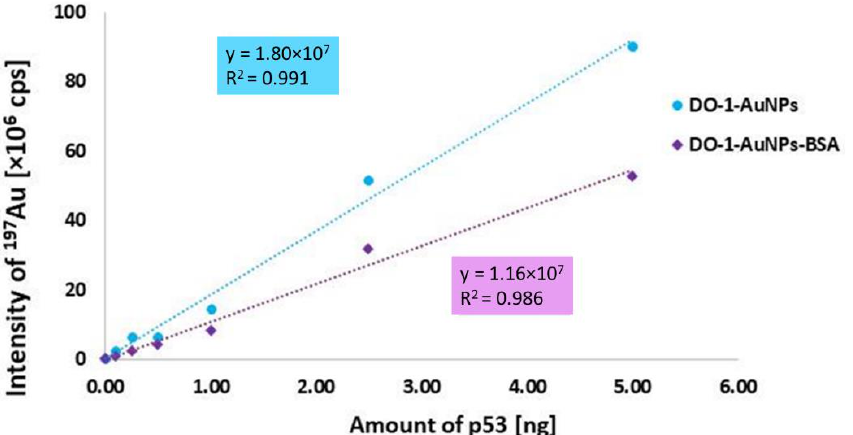
Figure 8. Calibration curves of p53 protein quantification using AuNPs-DO-1 and AuNPs-BSA .